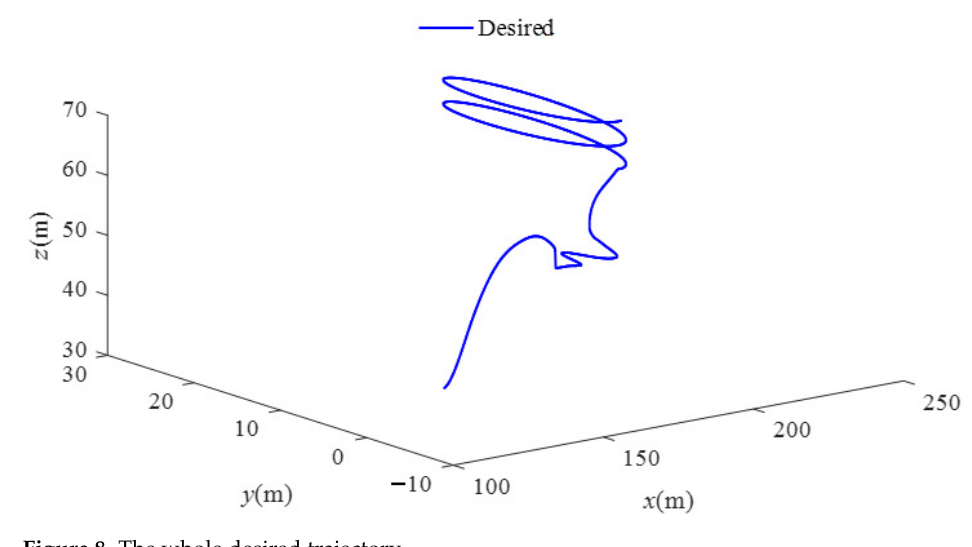
Figure 8. The whole desired trajectory.